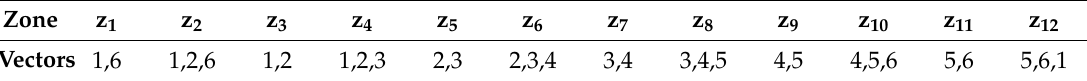
Figure 2. Decomposition of the grid period T in 12 zones in function of the line-to-line grid voltages (full lines) and their opposite (dashed lines). Table 3. Non-zero allowed switching vectors of the shunt converter for each voltage zone